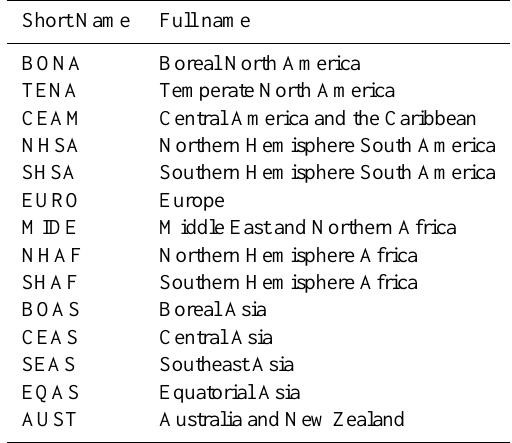
Table 1. Descriptions of the regions.